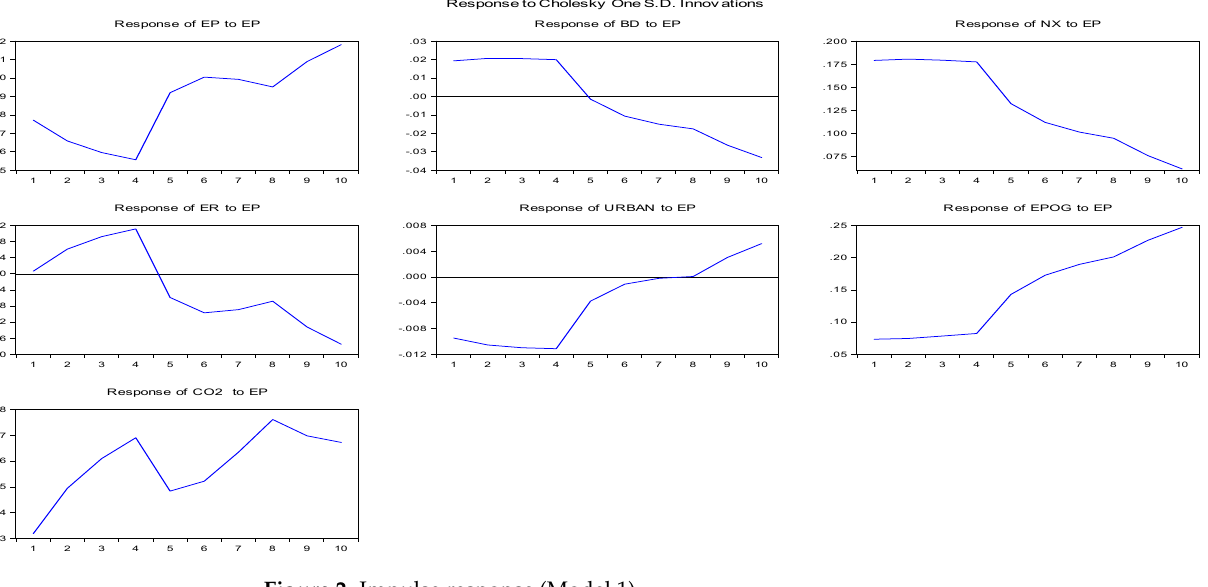
Figure 2. Impulse response (Model 1).